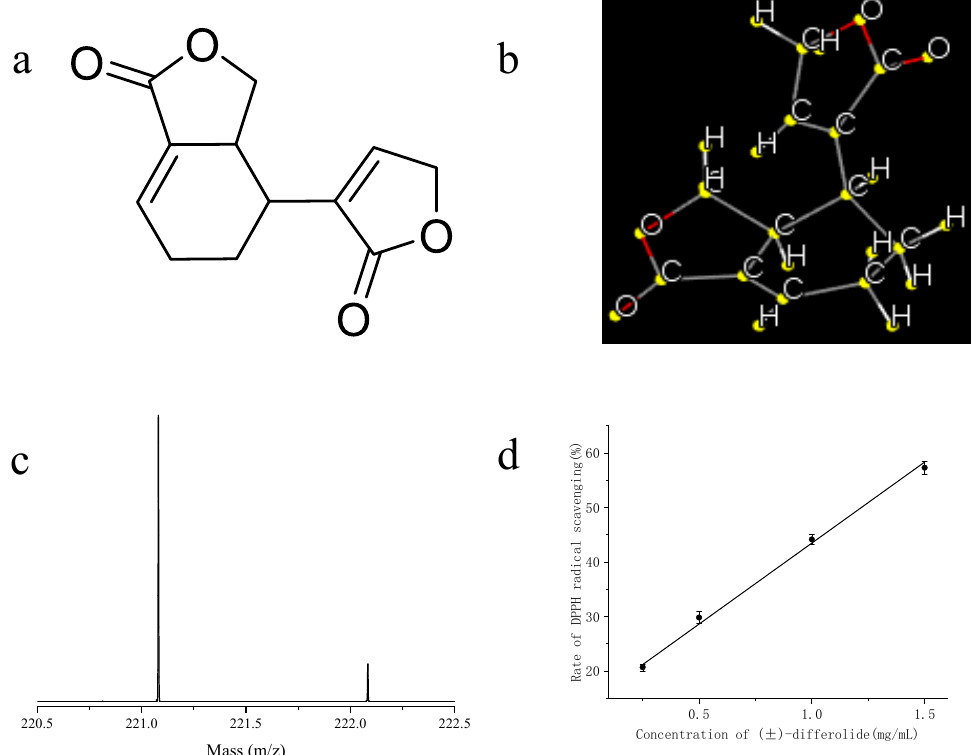
Figure 1. The structure and DPPH radical scavenging assay of (±)-differolide. ( a ): Structure of (±)-differolide; ( b ): X-ray crystal diffraction of (±)-differolide; ( c ): The m/z of (±)-differolide; ( d ): The rate of DPPH radical scavenging of (±)-differolide (in triplicate). Compound 1 was a pale yellow solid: 1 H NMR (400 MHz, DMSO- d 6 ) δ 7.32 (d, J = 2.2 Hz, 2H), 6.82 (p, J = 3.1 Hz, 2H), 4.91–4.74 (m, 5H), 4.46 (t, J = 9.1 Hz, 2H), 3.89–3.75 (m,